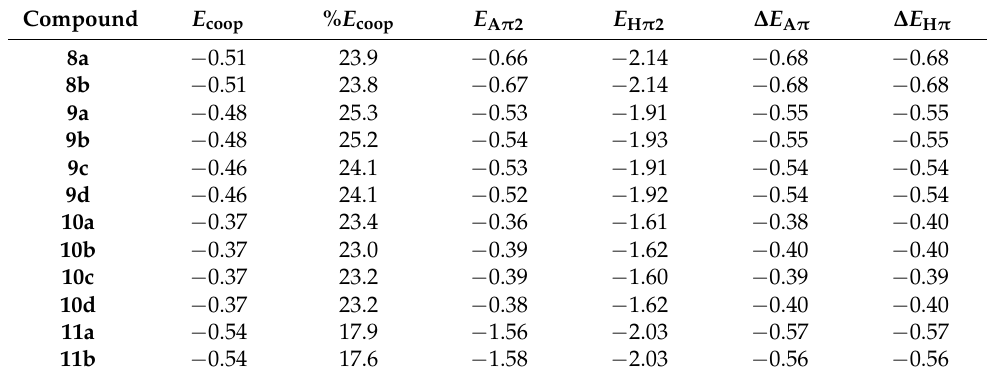
Table 2. Cooperativity ( E coop , in kcal/mol), interaction energies of three-component complexes 8 – 11 computed as a two-component system ( E A π 2 and E H π 2 , in kcal/mol) and their relationship with